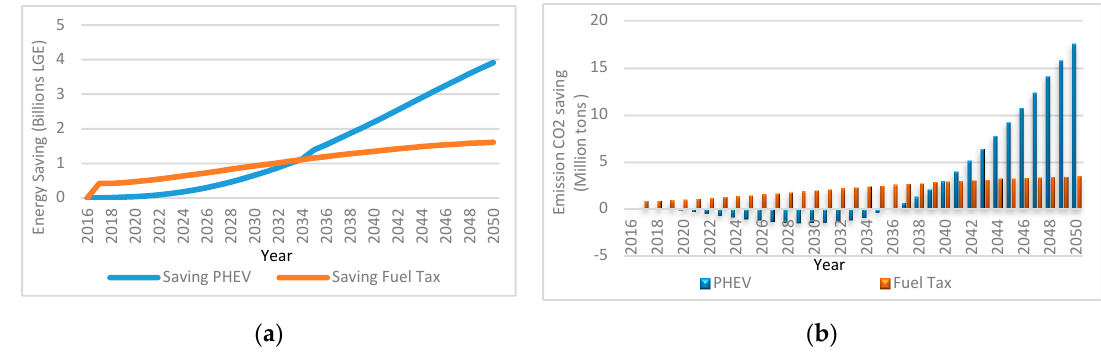
Figure 15. Comparison between scenarios for energy demands and CO 2 emission savings ( a ) Energy demand savings; ( b ) CO 2 emission savings.